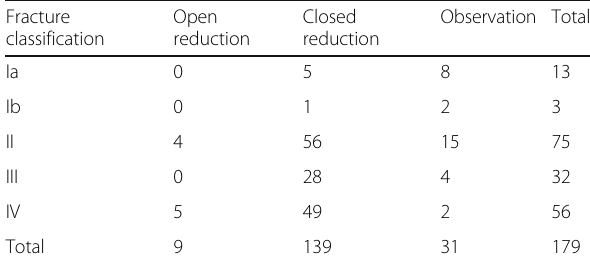
Table 4 Types of nasal bone fracture and